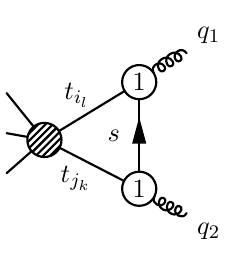
Figure 9 . Example for a soft fermion exchange one-loop